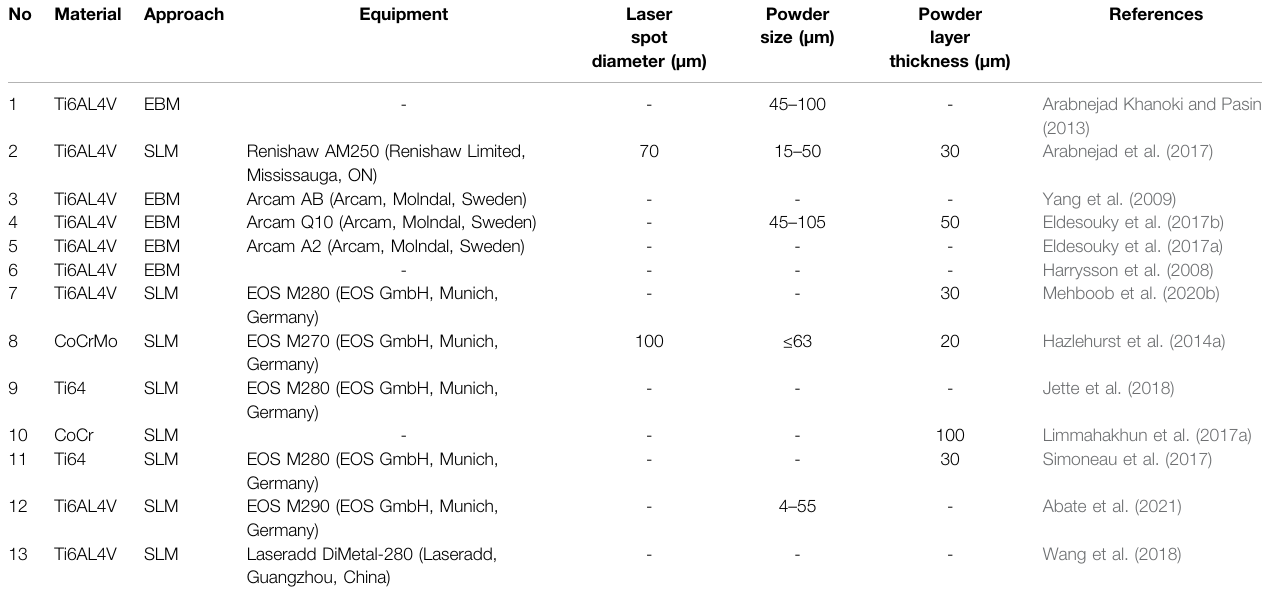
TABLE 2 | Materials and manufacturing methods of porous femoral